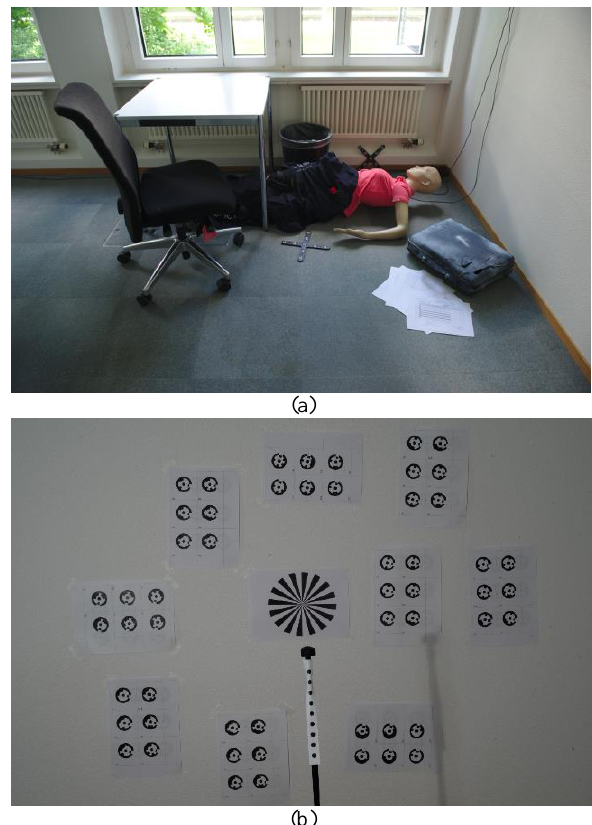
Figure 1. (a) The forensic scene representing a real case photogrammetric application. (b) A camera calibration field with Siemens star in the centre and dotted targets on a black pole as focus point in front of the calibration field.